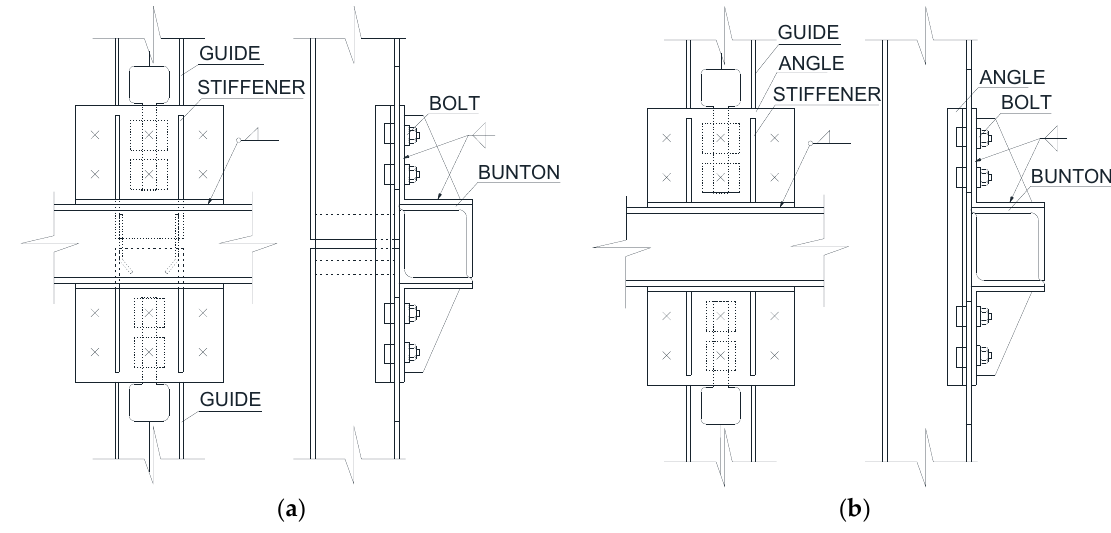
Figure 3. Guide-to-bunton connections ( a ) reaching two adjacent guides and ( b ) in the middle of a guide.